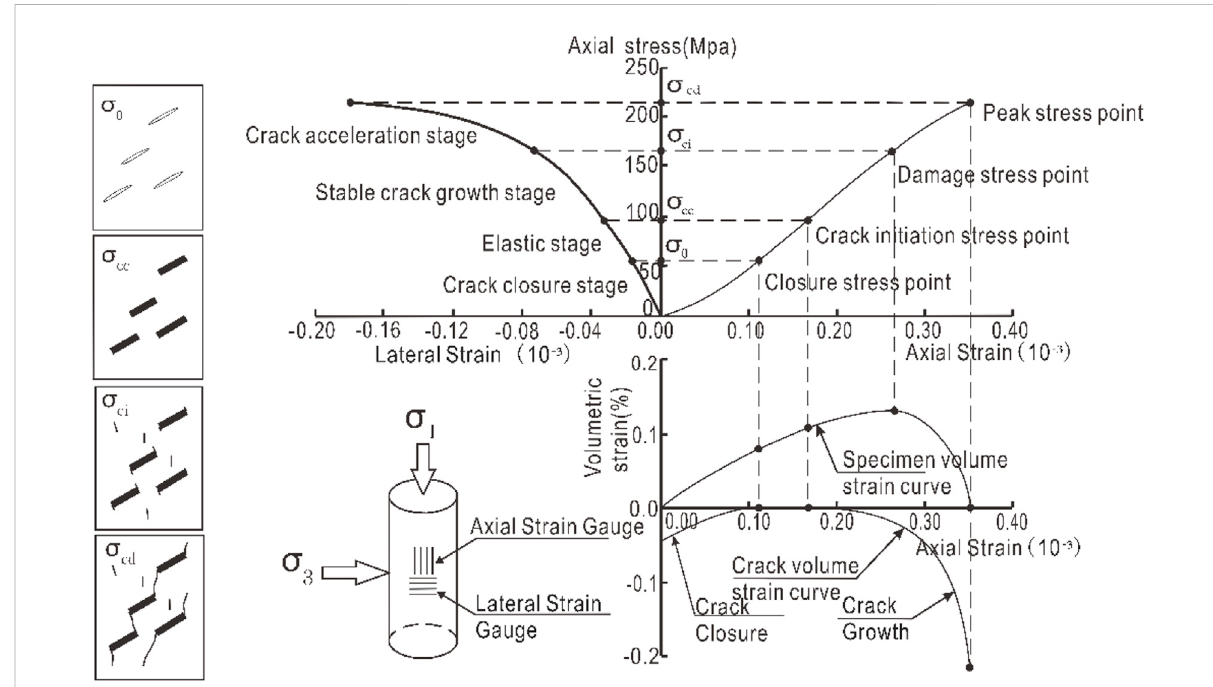
FIGURE 1 Schematic diagram of the division stage before rock peak damage (Brace et al., 1966; Cai et al., 2004).